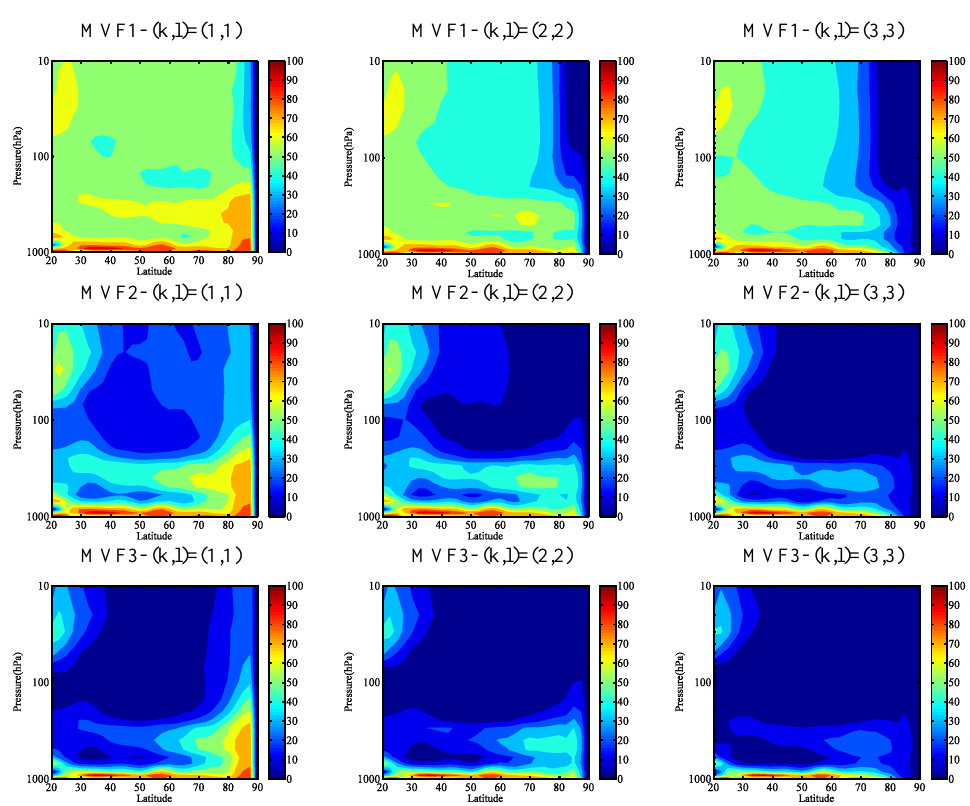
Figure A2. Probability of favorable propagation condition for Rossby waves derived from 50 winters (1961–2010) in the Northern Hemi- sphere based on different MVF values described in Fig. A1.